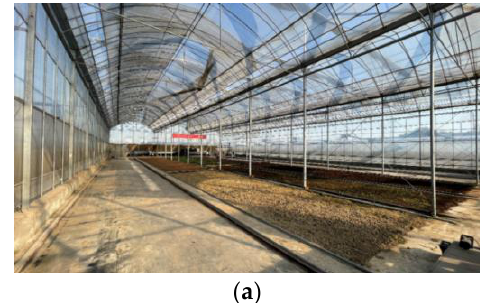
Figure 1. Magnetic positioning device diagram.